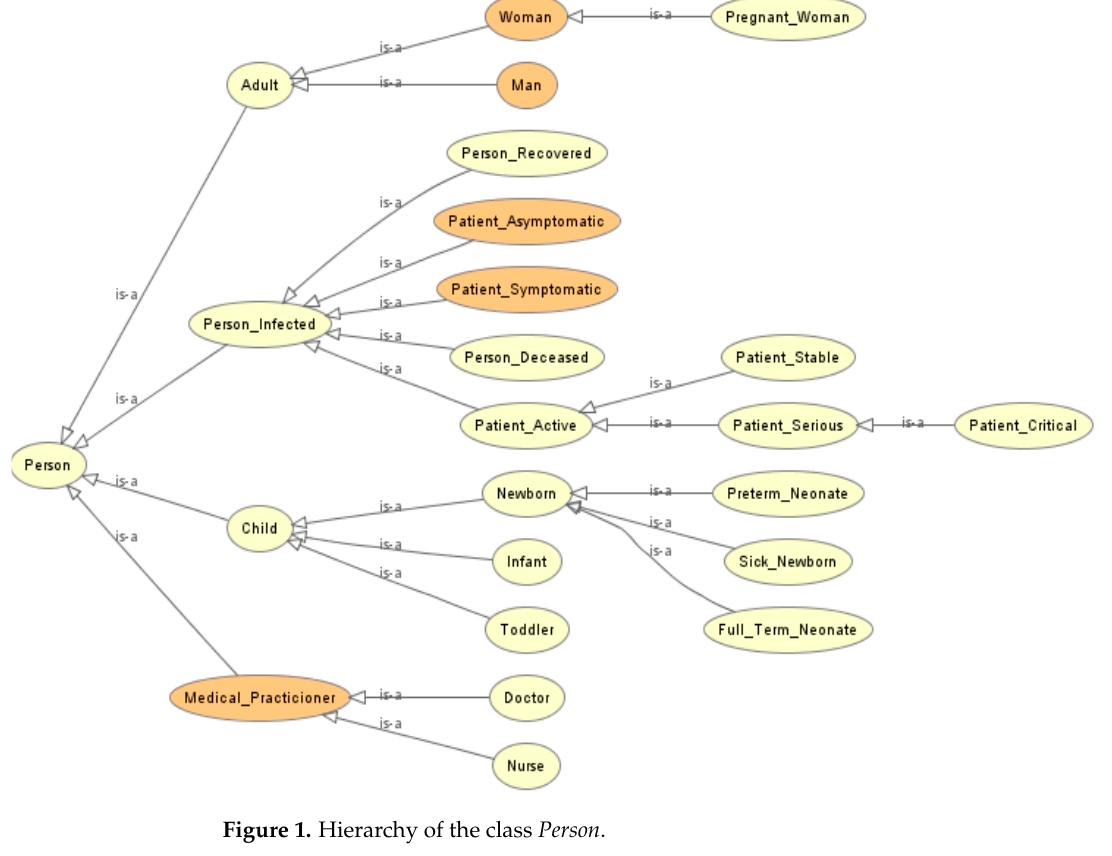
Figure 1. Hierarchy of the class Person.